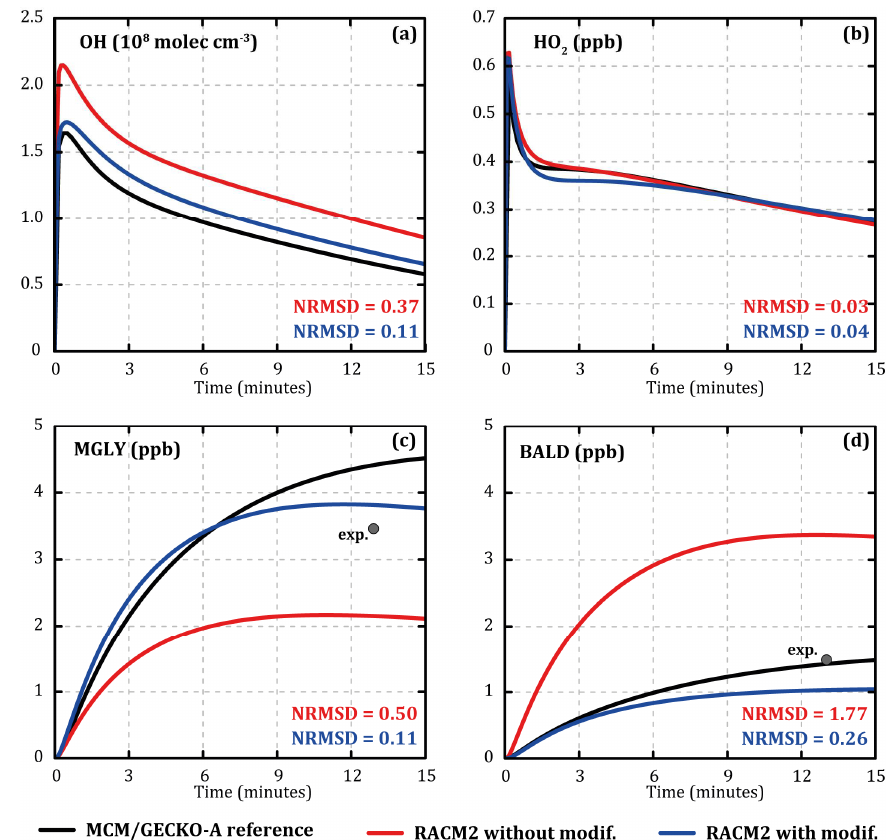
Figure 1. Temporal evolution of the concentrations of OH ( a ), HO 2 ( b ), methylglyoxal ( c ), and aromatic aldehydes ( d ) simulated with MCM/GECKO-A (black lines), RACM2 (red lines), and modified RACM2 (blue lines) during toluene oxidation. Results are shown for oxidation performed at a temperature of 7 °C, an RH of 24%, 120 ppb of IPN, and 112 ppb of toluene. Grey points represent the outlet experimental concentrations. Table 3. Modified RACM2 reactions (reaction numbers are those from Goliff et al. [8]). Reaction